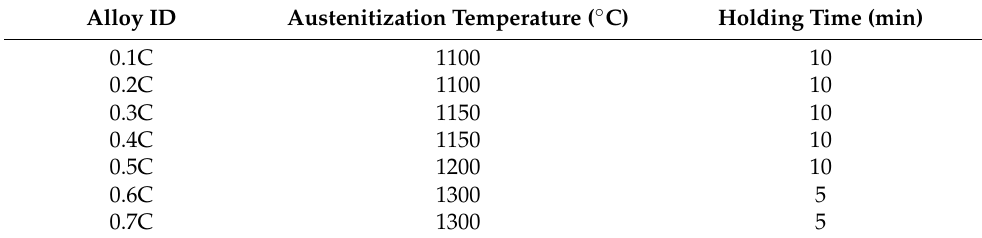
Table 2. Overview of alloy-specific austenitization